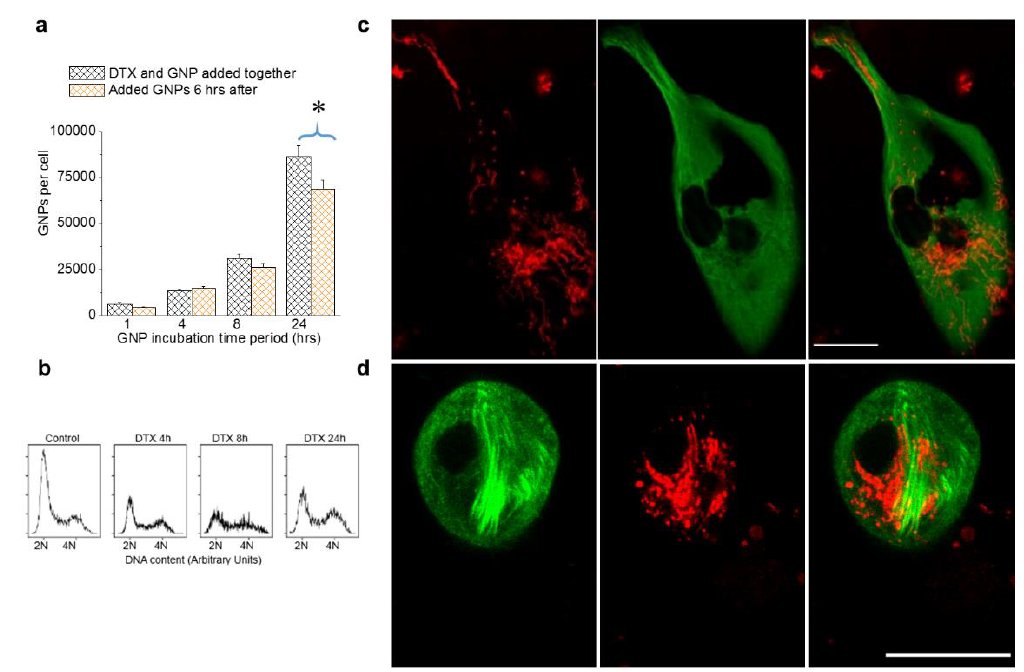
Figure 6. The relative timing of DTX and GNP inoculation in MDA-MB-231 cells treated with 0 and 50 nM DTX. ( a ) Variation in intracellular GNP accumulation with simultaneous addition of GNP and DTX vs. GNPs added 6 hrs after the addition of DTX. ( b ) Cell cycle analysis for control cells and cells treated with 50 nM DTX after 4, 8, and 24 h. ( c–d ) Images of individual cells treated with 0 and 50 nM DTX, respectively. Vesicles containing GNPs and MTs are marked in red and green, respectively. Scale bar is 20 µm. Error bars are standard deviations from 3 replicate measurements. * Represents a statistically significant difference (Welch’s unequal variance t -test, p < 0.05).